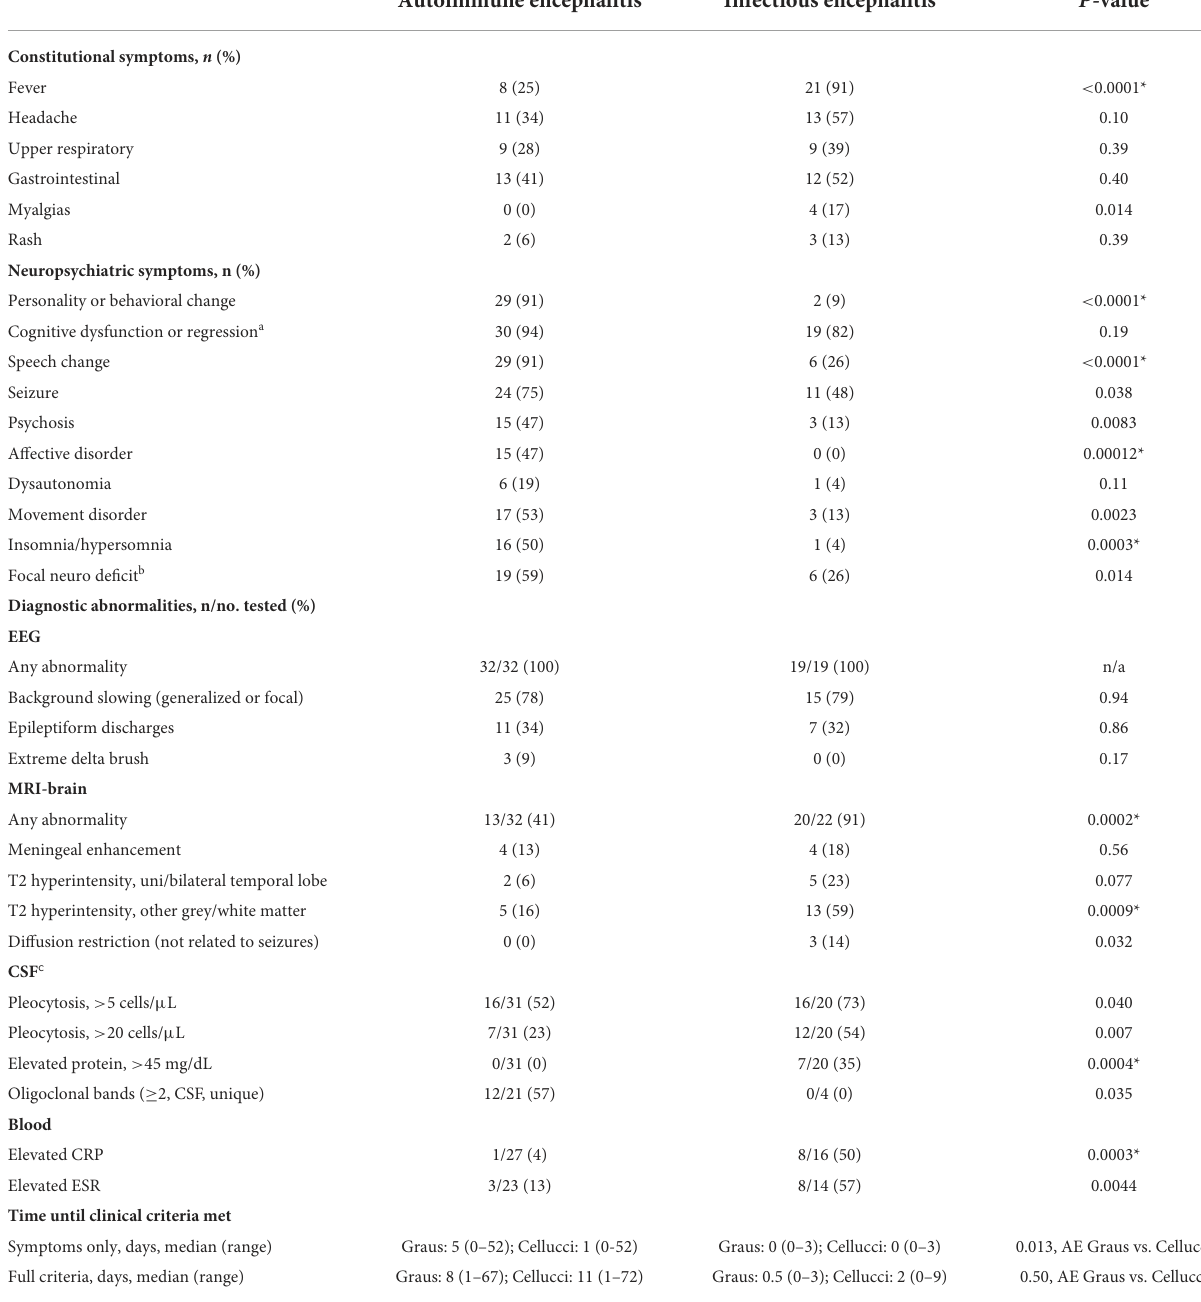
TABLE 2 Clinical symptoms and paraclinical diagnostic testing in AE and IE. Autoimmune encephalitis Infectious encephalitis P